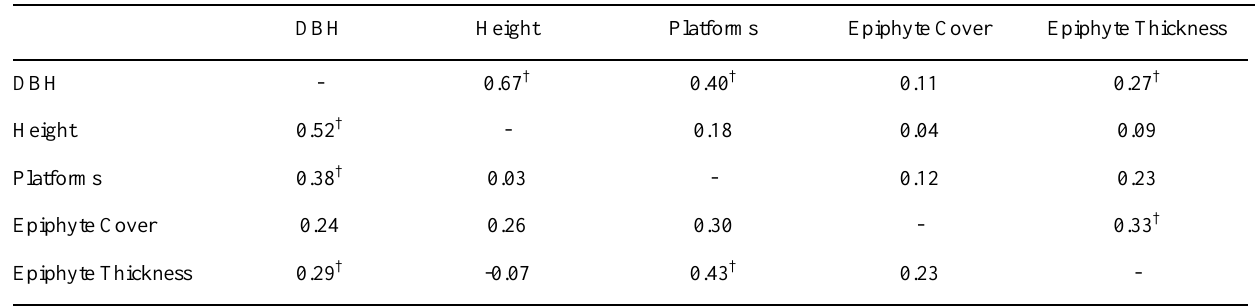
Table 3. Spearman rank correlations show that nest trees that were distinct when compared with neighboring canopy trees (above diagonal; n = 59, except n = 57 for epiphyte cover, and n = 53 for epiphyte thickness) and neighboring platform trees (below diagonal; n = 40, except n = 36 for epiphyte cover, and n = 32 for epiphyte thickness) are often distinct in other dimensions as well. DBH = diameter at breast height. DBH Height Platforms Epiphyte Cover Epiphyte Thickness DBH - 0.67 † 0.40 † 0.11 0.27 † Height 0.52 † - 0.18 0.04 0.09 Platforms 0.38 † 0.03 - 0.12 0.23 Epiphyte Cover 0.24 0.26 0.30 - 0.33 † Epiphyte Thickness 0.29 † -0.07 0.43 † 0.23 - † Spearman rank correlation P <